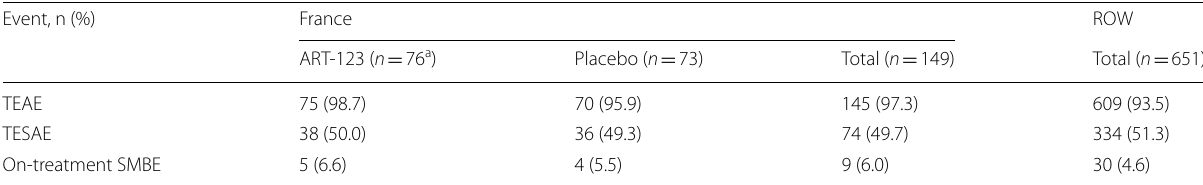
ROW rest of world (excluding France), SMBE serious major bleeding event, TEAE treatment-emergent adverse event, TESAE treatment-emergent serious adverse event a One patient randomized to the placebo group received a dose of